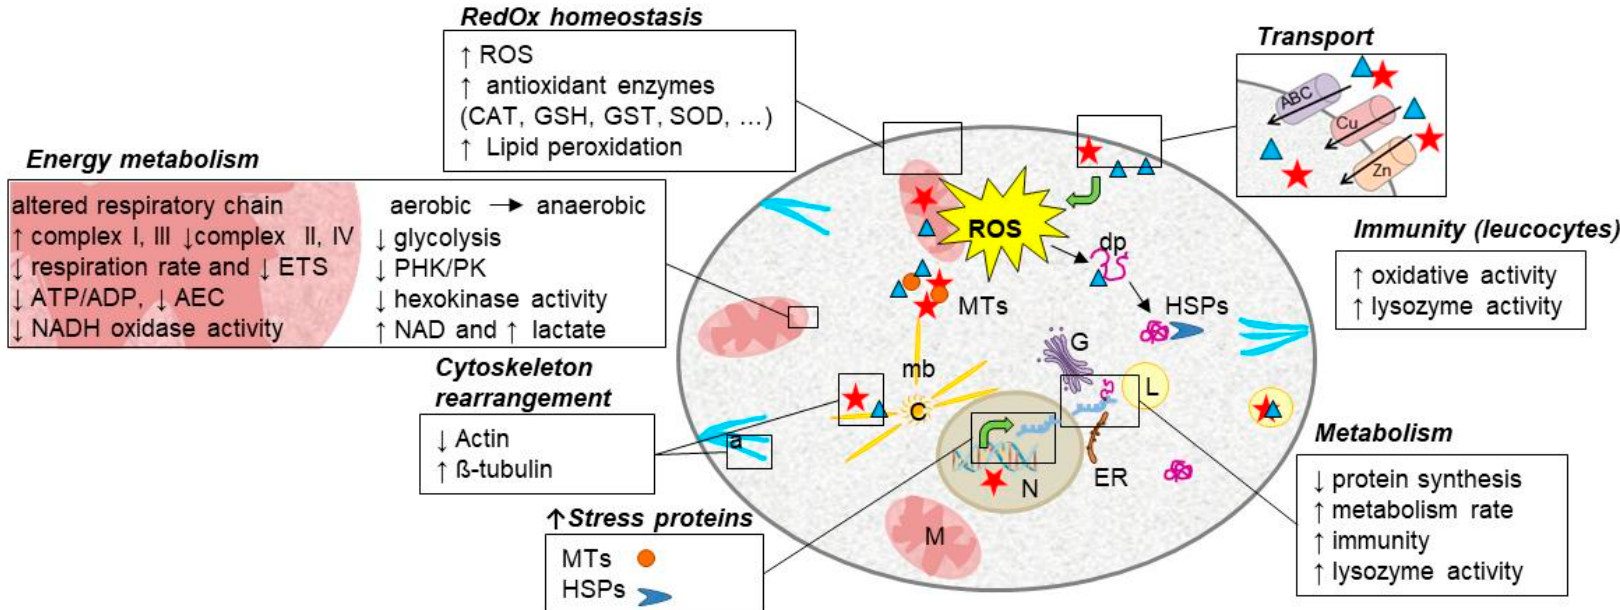
Figure 2. Exposure to toxic metals in aquatic animals triggers common toxicity pathways (ABC: ABC transporter; a: actin; C: centrosome; dp: denatured protein; L: lysosome; ER: endoplasmic reticulum; G: Golgi; HSPs: heat shock proteins; M: mitochondria; mb: microtubules; MTs: metallothioneins; N: nucleus; ROS: reactive oxygen species). Table 3. Summary of studies describing metal impacts on cytoskeleton rearrangement.